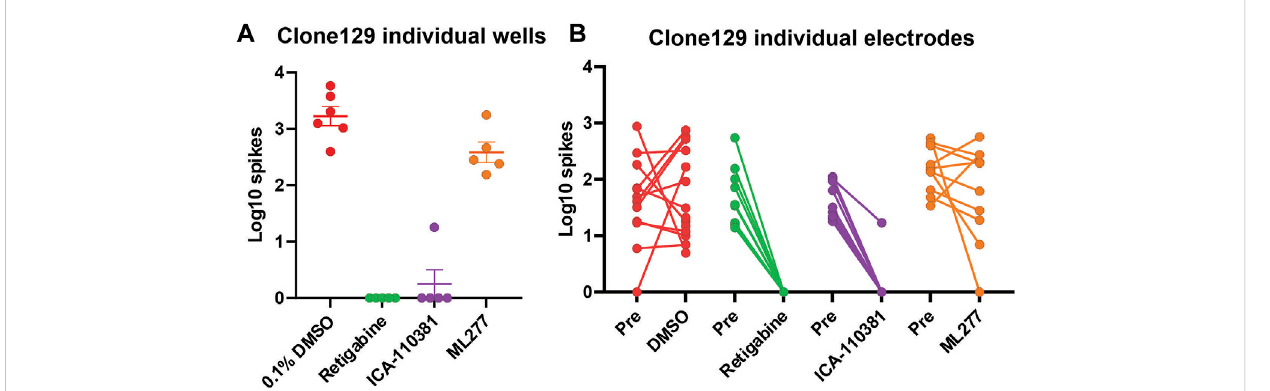
FIGURE 2 Relative response of Kv7 selective compounds. Spontaneous spiking activity of human iPSC-derived sensory neurons (clone 129) plated into the wells of a 48-well MEA plate. (A) The Log10 count of total spikes per well observed for a 10 min recording period at 37 ° C is displayed with a symbol for each well. The data groupings showed relatively equal means and SEM before treatment with the indicated compounds all at the same concentration of 3 µM. Both retigabine and ICA-110381 signi fi cantly reduced spontaneous spiking activity ( p < 0.001) while ML277 showed a small but not signi fi cant reduction of activity ( p = 0.54) compared to vehiclecontrol. (B) The overall well responses were mirrored at the level of individual electrodes which likely represent the activity of individual sensory neurons as shown in the before and after